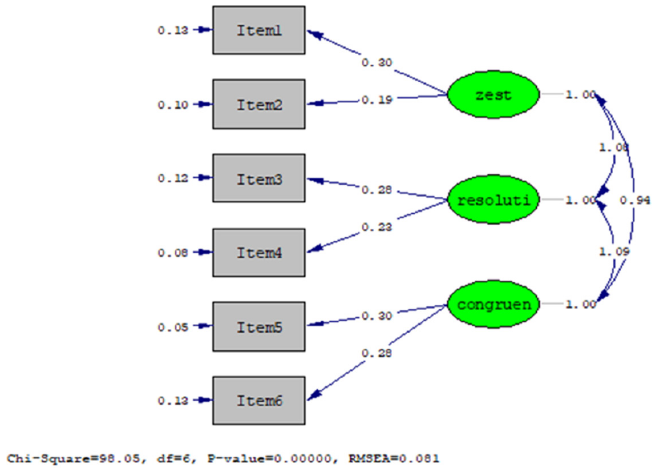
Figure 1. Results from the one-order factor analysis of the LSI-SF. Table 5. Correlation coefficients between the dimensions of the LSI-SF. 2. Discriminant Validity: The three dimensions of the LSI-SF had significance ( p < 0.05), and the confidence intervals of the three dimensions did not contain 1.00 (Table 5).